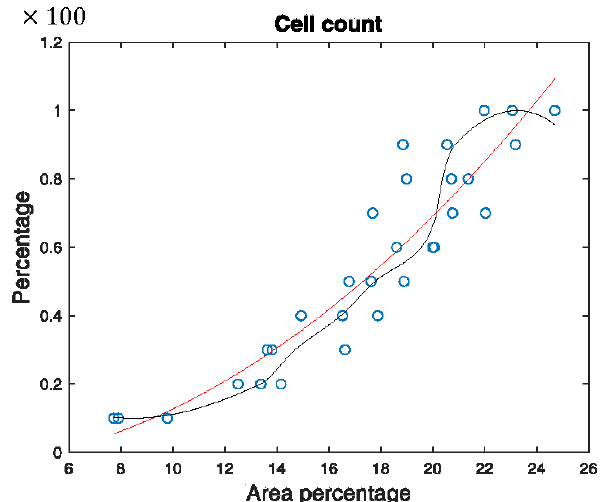
Figure 4. Regression models of the training data. There were 30 cell confluence images. The circle points represent the 30 data points. The red curve is the quadratic model and the black curve is the shape-preserving cubic interpolation.